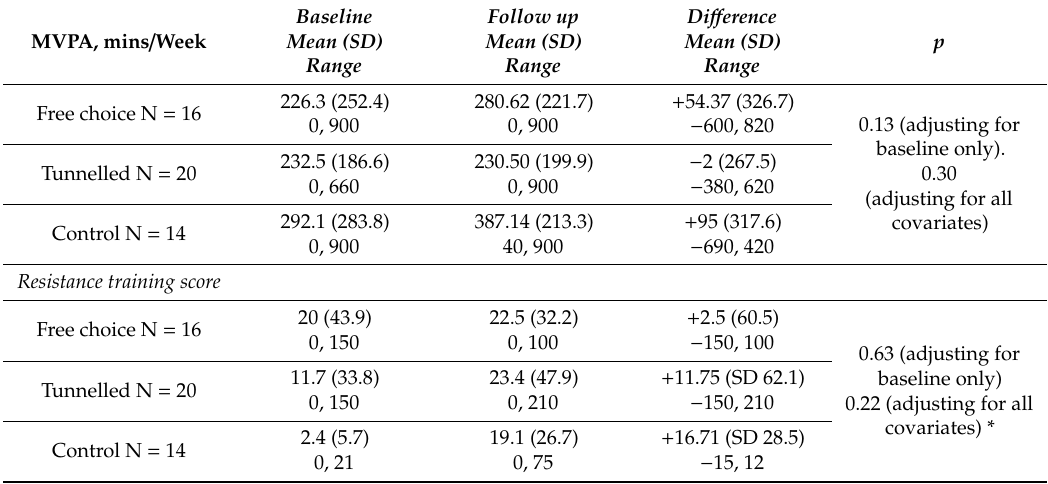
Table 2. Physical activity